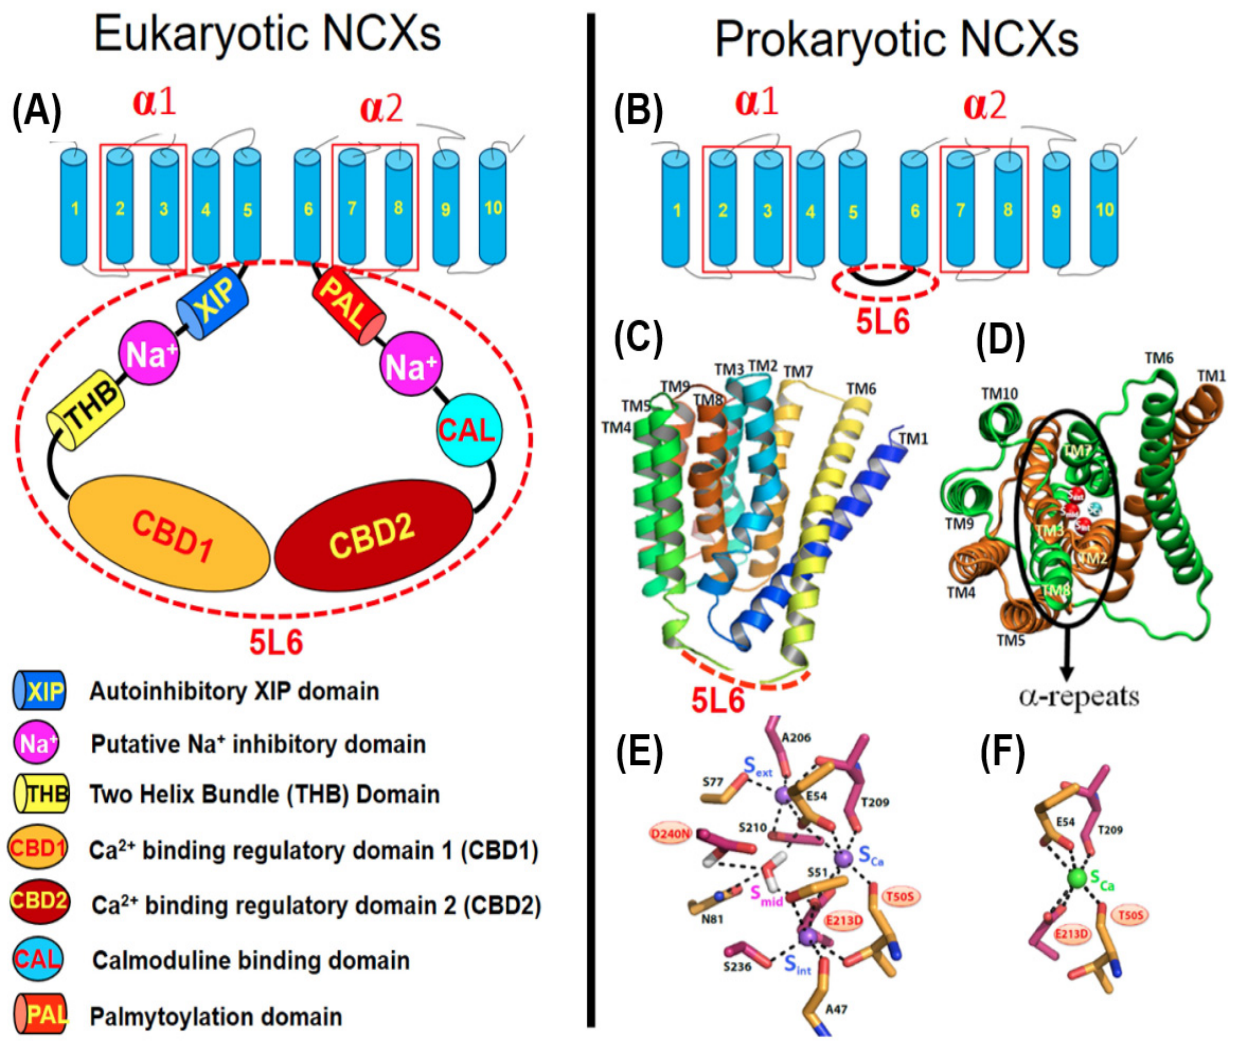
Figure 1. Structure-topological arrangements of prokaryotic and eukaryotic NCX proteins. Eukary- otic ( A ) and prokaryotic ( B ) NCX proteins consist of 10 trans-membrane helices (TM1–10), where highly conserved α -repeat regions form a four-helix ion passageway with TM2/TM3 ( α 1 ) and TM7/TM8 ( α 2 ) bands (shown boxed). Eukaryotic NCXs contain a very long ( ~ 520 residues) cytosolic 5L6 loop (f-loop) between TM5 and TM6 with the Ca 2+ binding regulatory domains, CBD1 and CBD2. In the lack of regulatory domains, the 5L6 loop of prokaryotic NCXs is very short (12–16 residues). ( C ) The crystal structure of the archaeal NCX_Mj protein (PDB 3V5U) in the OF orientation describes a tightly packed core of eight helices (TM2-TM5 and TM7–TM10), where two long and loosely